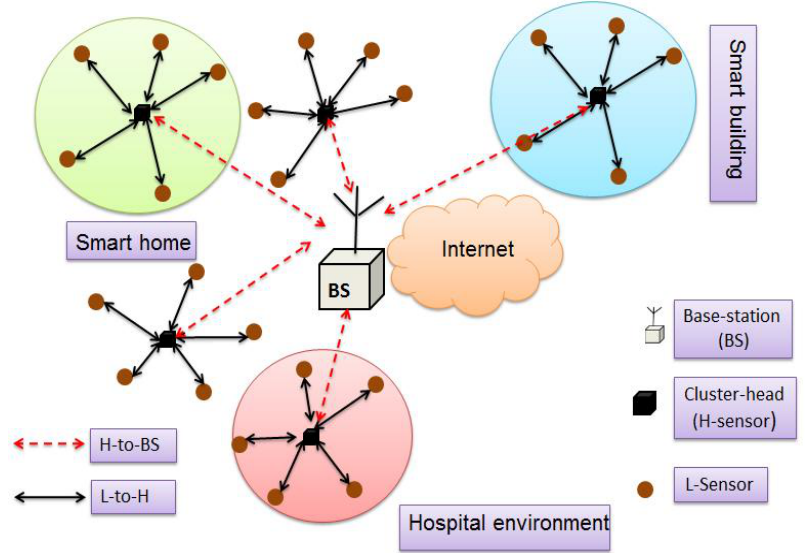
Figure 1. A system model for distributed WSN